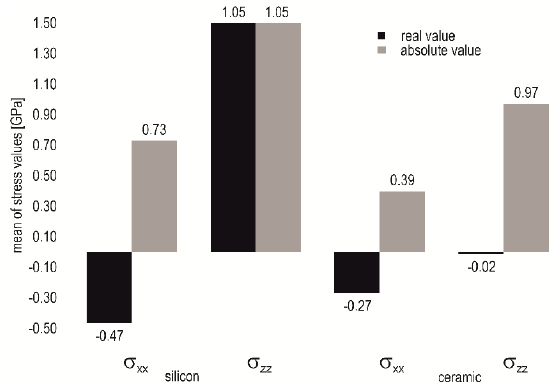
Figure 12. Comparison of the process means based on real and absolute stress value on silicon and ceramic substrate.